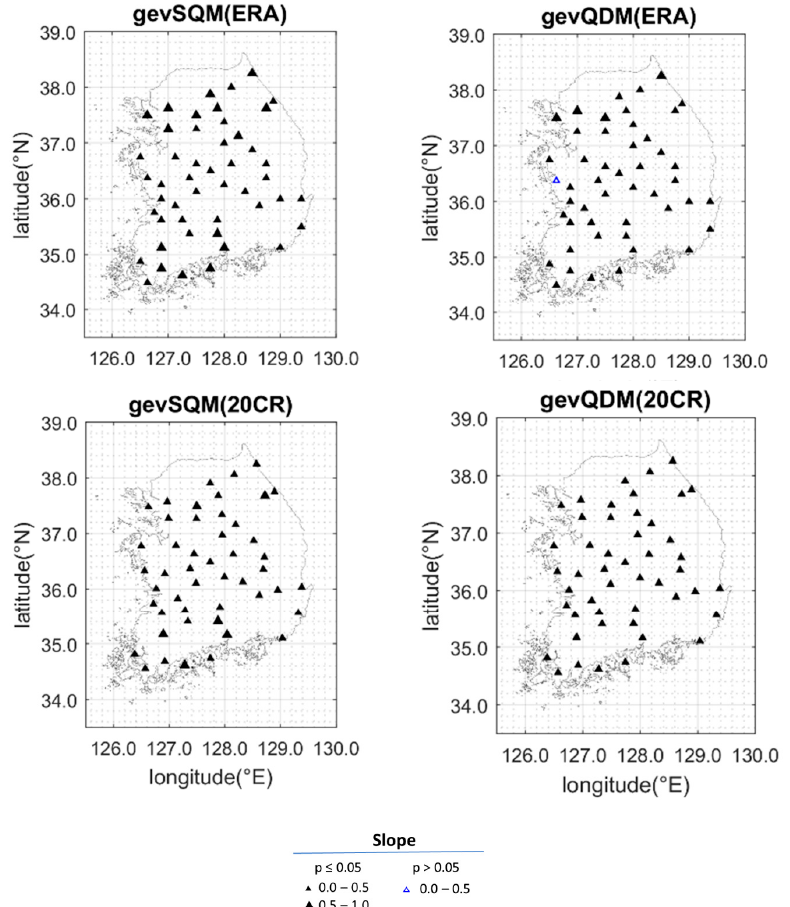
Figure 8. The trends in the AMRs of the bias corrected ERA ‐ 20c and 20CR by QM approaches as in Figure 7, but the data period is covered from 1900 to 2010. To evaluate the magnitude of the trends, inter ‐ annual variabilities over 48 stations from 1900 to 2010 were also analyzed as illustrated in Figure 9. Individual values for each station are presented with thin weak blue and red lines for ERA ‐ 20c and 20CR, respectively, while the means of 48 stations are presented with thick strong blue and red lines. Although there was the difference in specific movements between ERA ‐ 20c and 20CR, the trends of the overall means for 48 stations represented by bold blue color for ERA ‐ 20c and bold red color for 20CR illustrate the significant increasing trends for both cases.